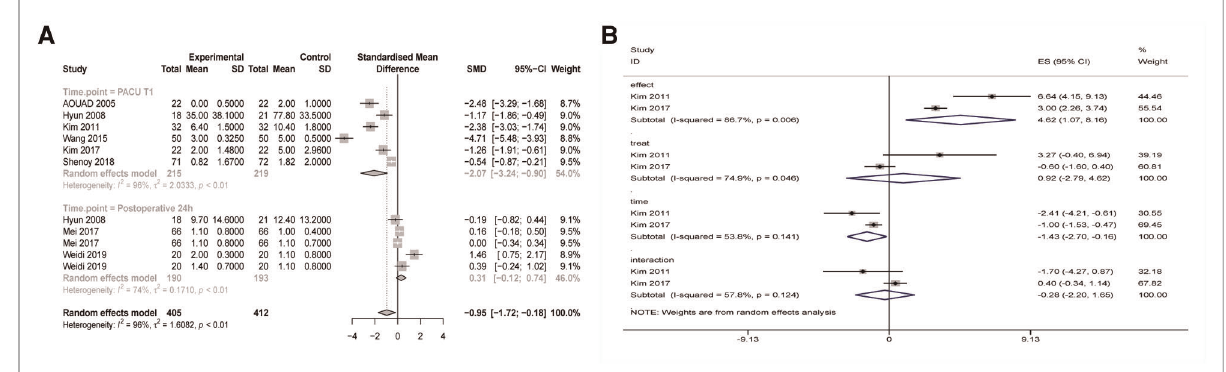
FIGURE 5 ( A ) Forest plot of regional anesthesia on POD score. ( B ) Forest plot of multilevel analysis on POD